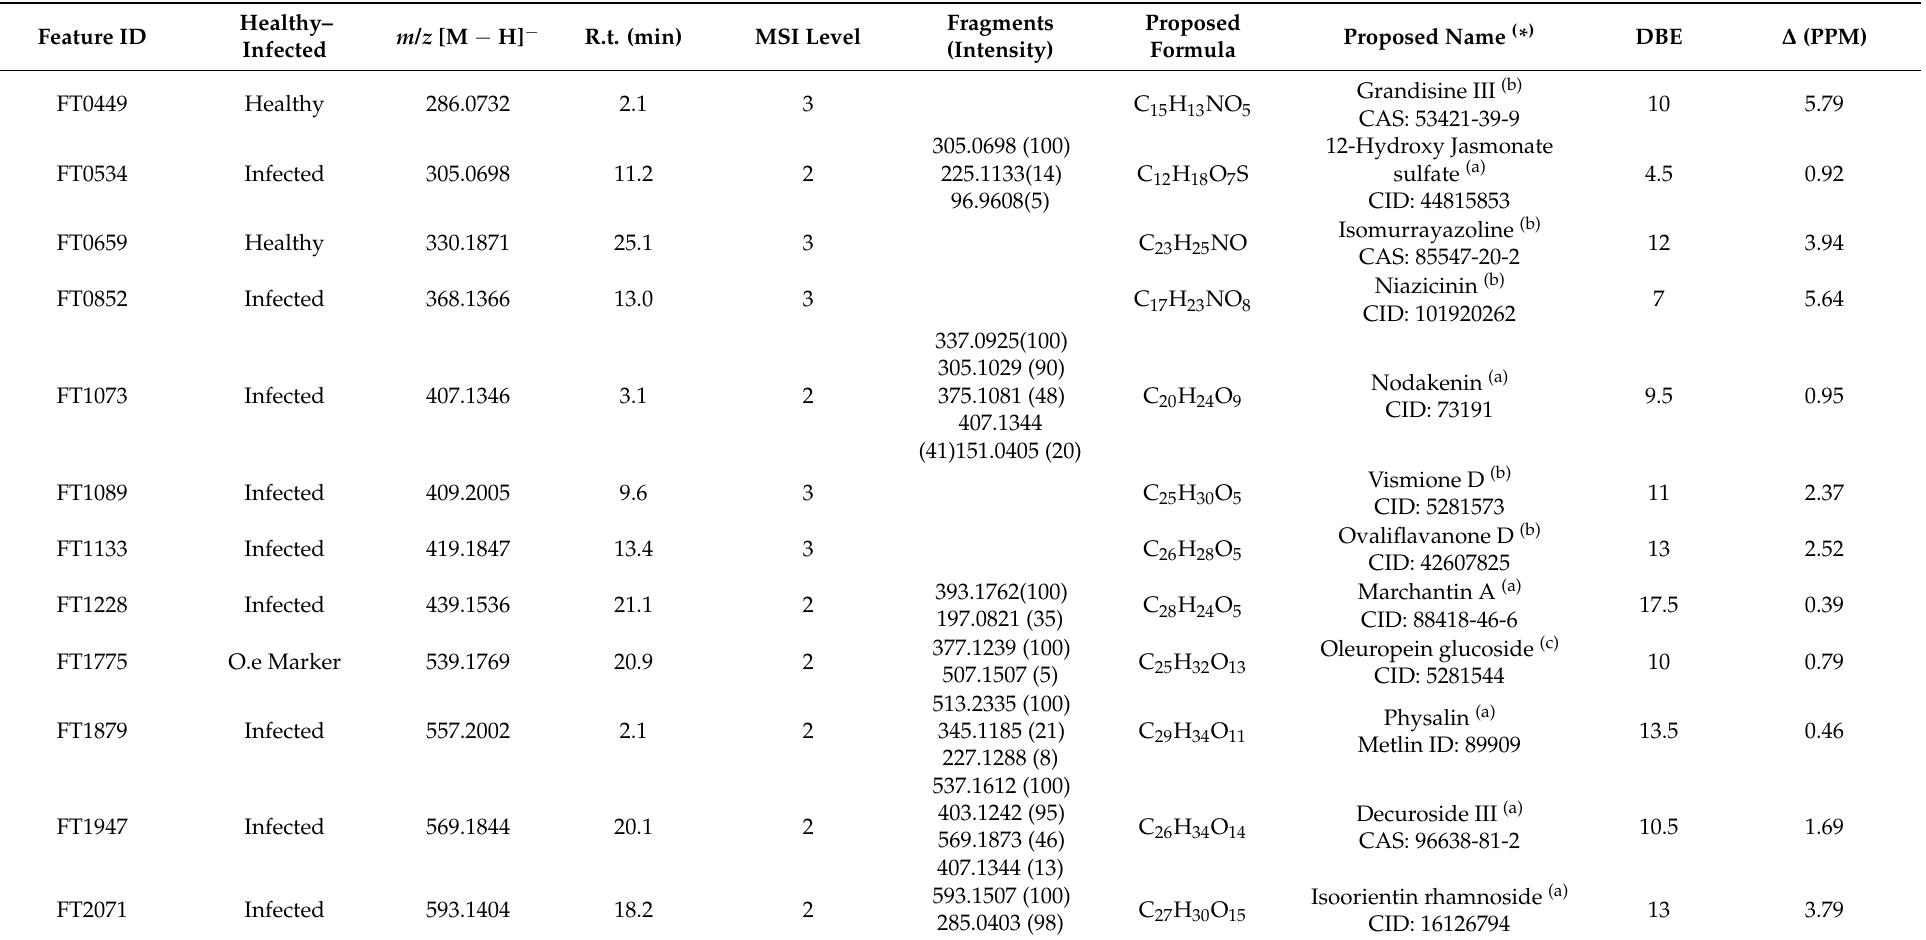
Table 1. Annotated molecules; each feature is specified whenever it is a health or infection marker or a reported species-specific marker (O.e Marker) for Olea europaea . The table also reports the double bond equivalent (DBE) and the mass accuracy shift in